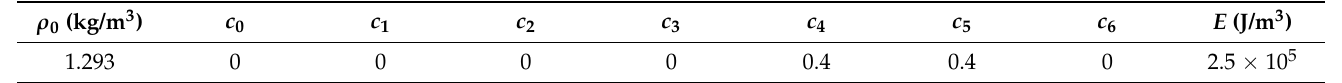
Table 2. Air material model and EOS parameters [25].